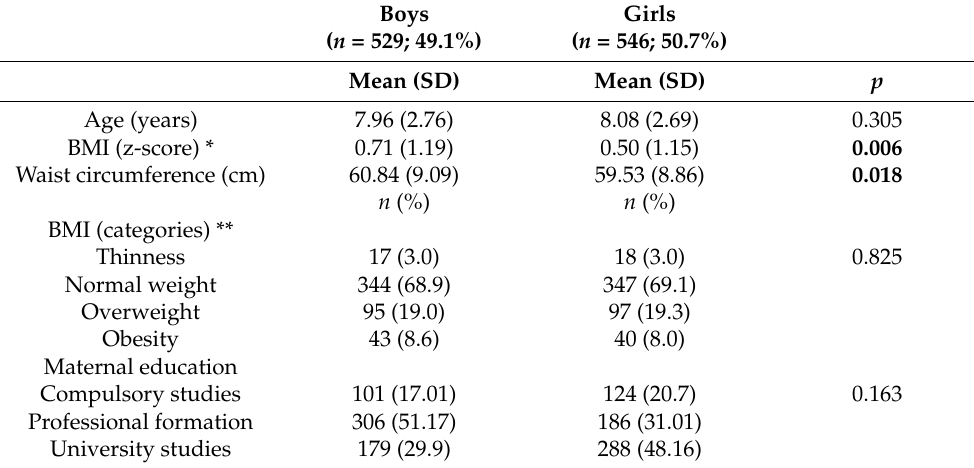
Table 1. Descriptive characteristics of the sample participating in the study ( n = 1075).